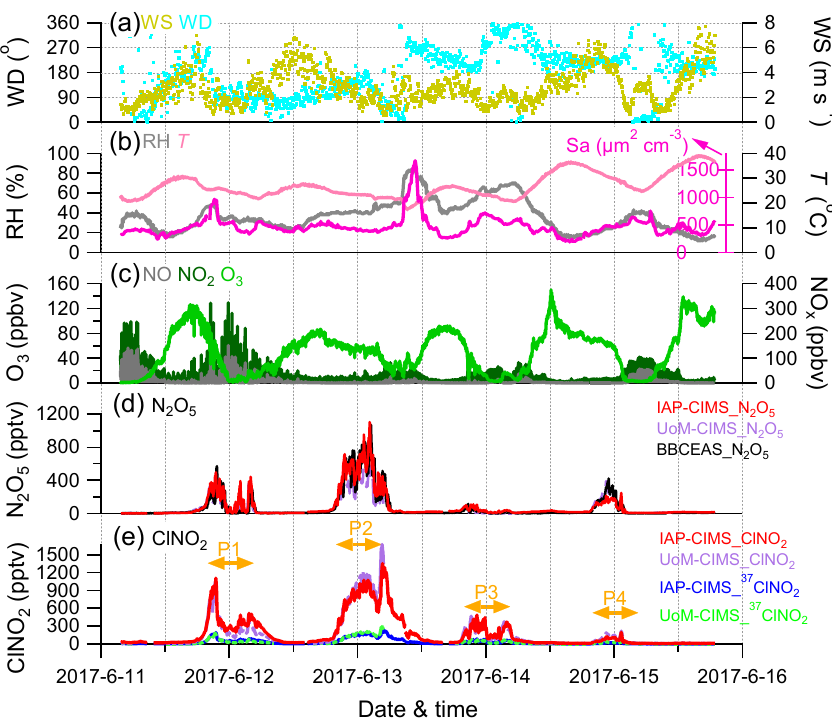
Figure 1. Time series of (a–b) meteorological parameters (WS, WD, RH, T ) and surface area density ( S a ), (c) trace gases (O 3 , NO, NO 2 )